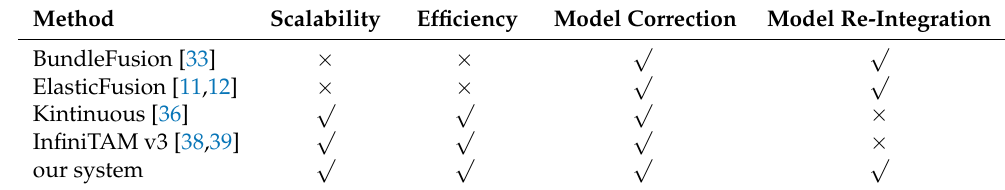
Table 1. The characteristics of the prior state-of-the-art dense mapping systems and our